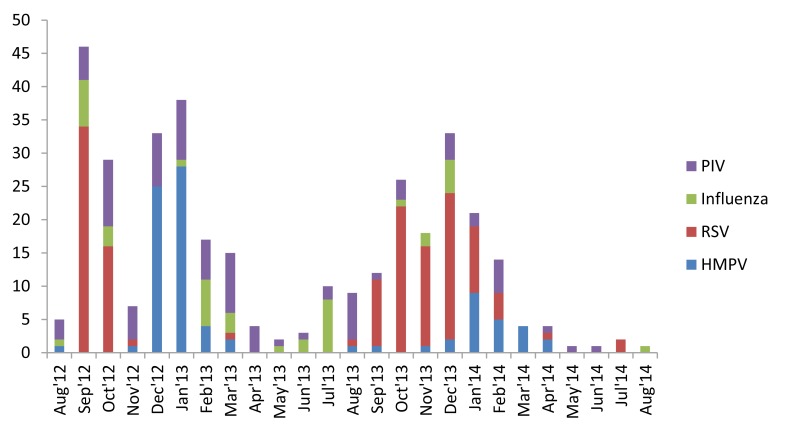
Seasonality of respiratory infections among the study children in Ballabgarh, northern India, 2012-14. hMPV – Human metapneumo virus, RSV – Respiratory syncytial virus, PIV – Para-influenza virus.